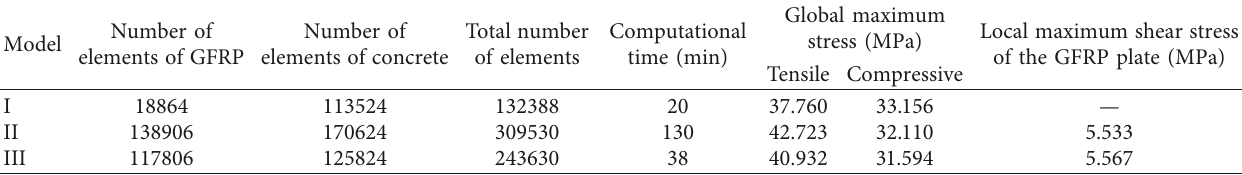
Table 4: Comparisons of the three different FEA